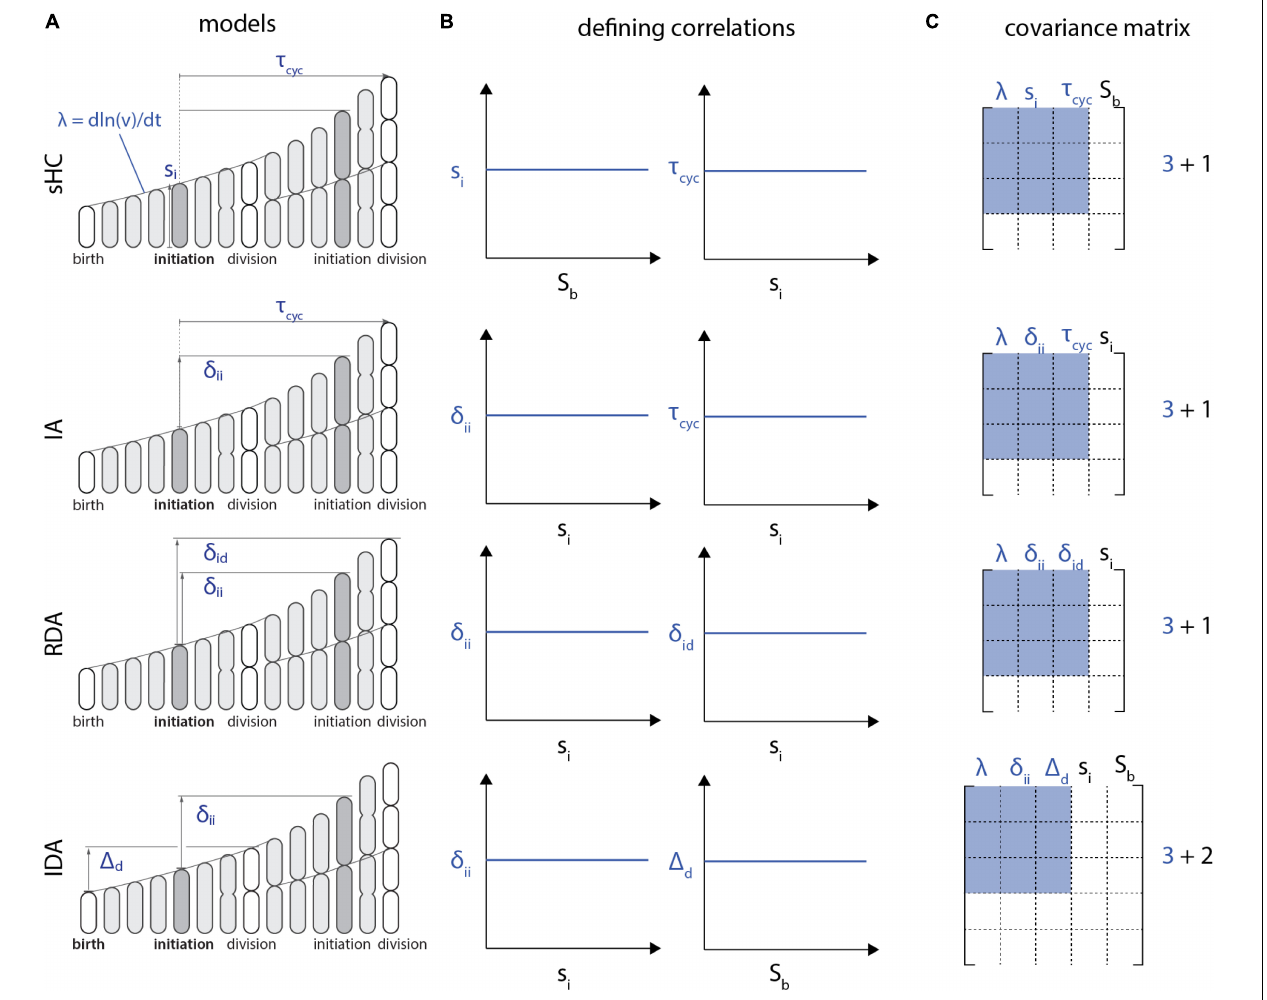
FIGURE 4 | Each model (A) is characterized by a set of two correlations (B) . Note that these defining correlations require 1 additional parameter S b for the sHC model, 1 additional parameter s i for the RDA and the IA models, whereas the IDA model requires 2 additional parameters, s i and S b . (C) As a result, the covariance matrix for the I -value analysis of these models, according to Witz et al. (2019), would be 4x4 for the sHC, IA and RDA models and 5x5 for the IDA model. Therefore, the I -values of these models cannot be meaningfully